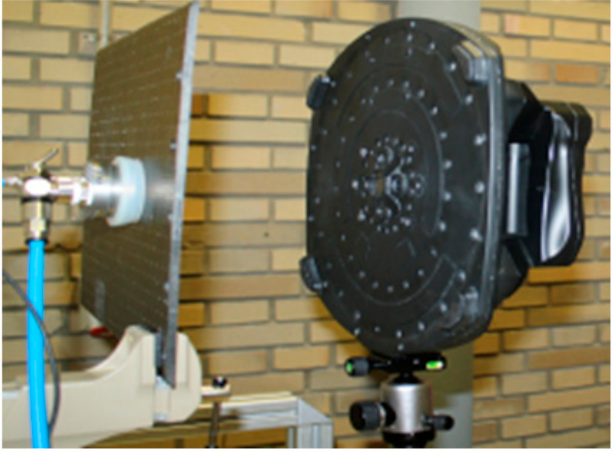
Figure 18. SoundCam setup for full field AE imaging.